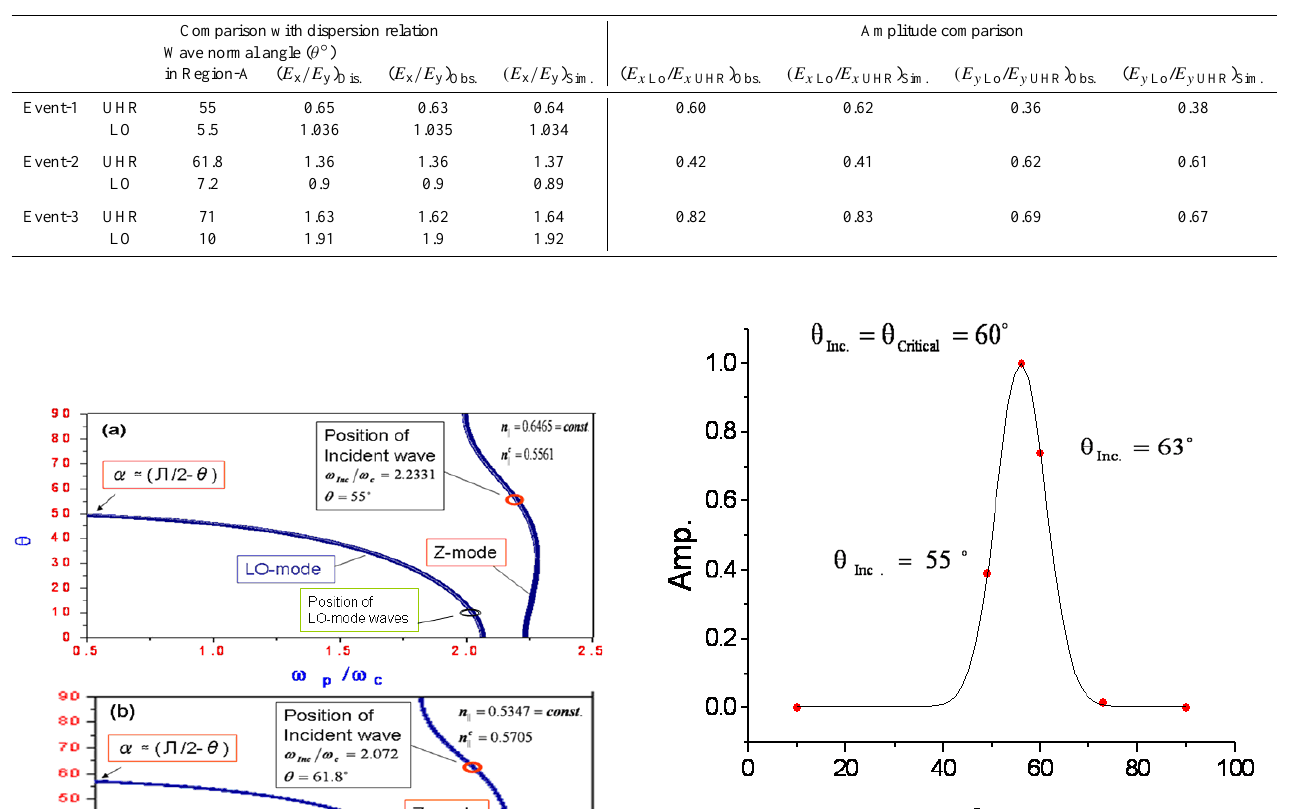
Table 2. Summary of simulation results. The left column shows a comparison with the dispersion relation for both observation and simulation for incident and LO-mode waves. The right column shows an amplitude comparison between simulation results and observations.